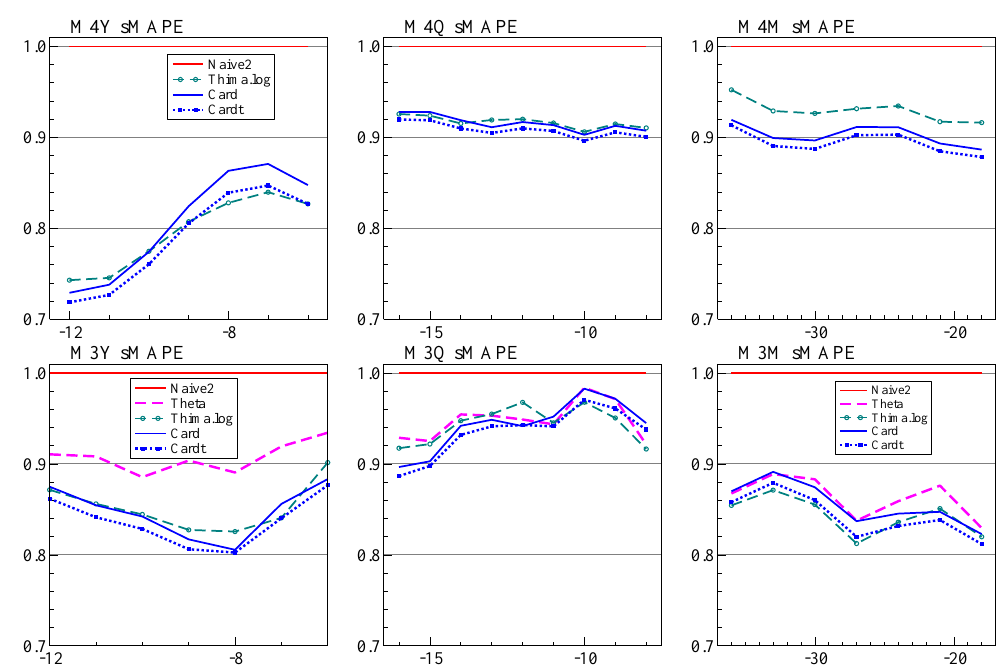
Figure 11. H -step forecast accuracy relative to that of Naive2 . Forecast methods are Card , Cardt , THIMA.log .